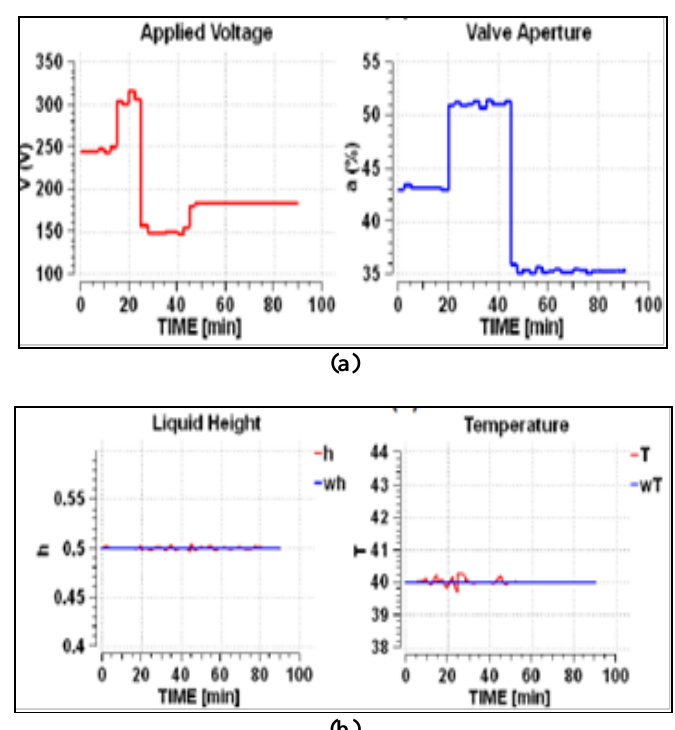
Figure 7: (a) Manipulated and (b) controlled